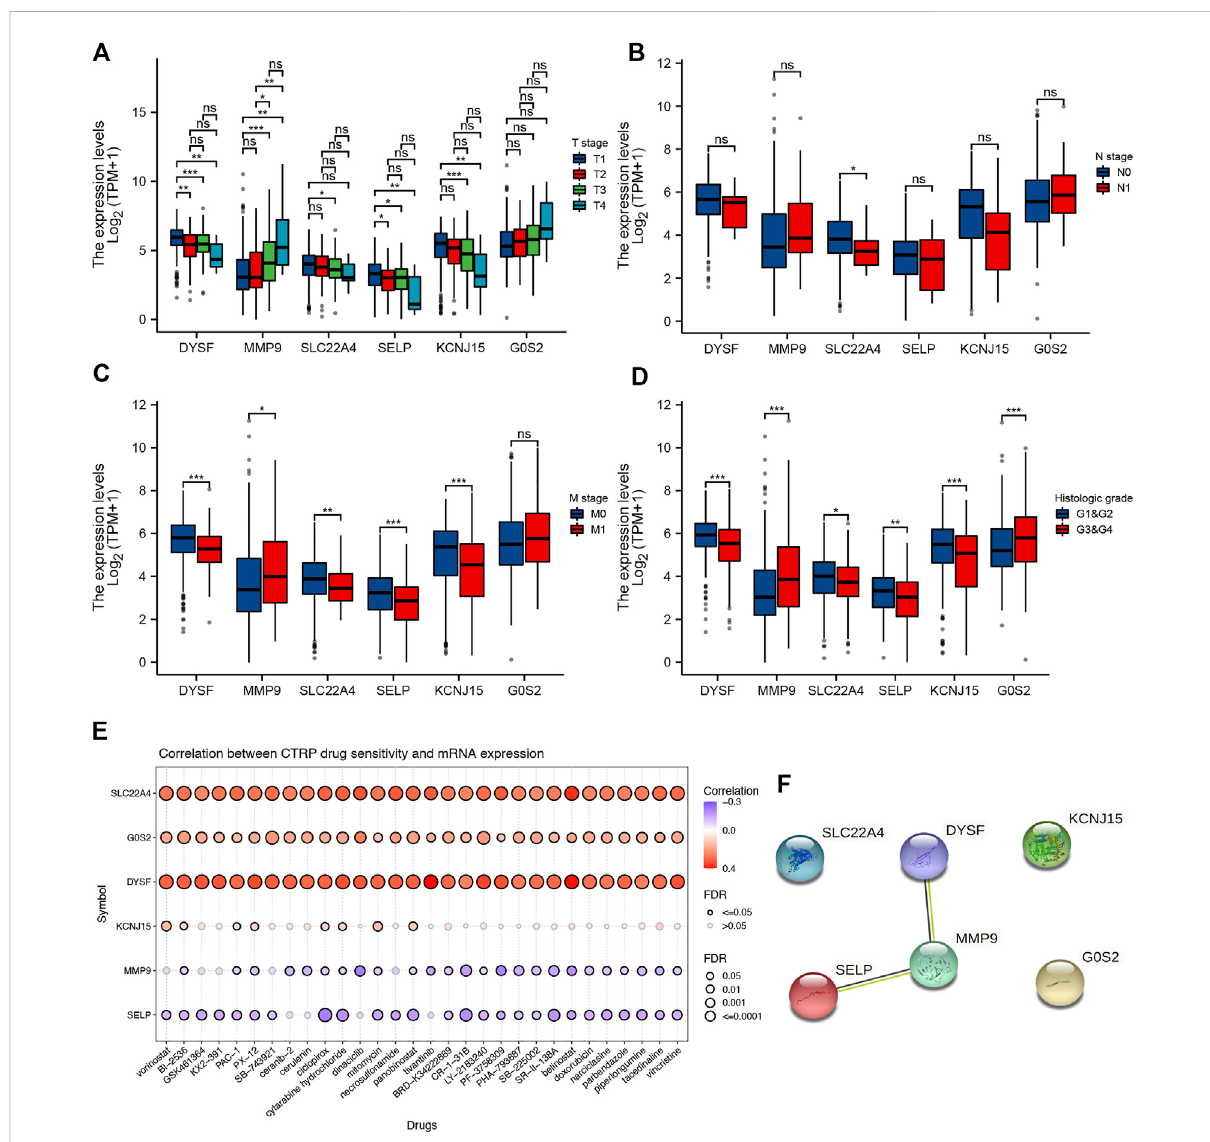
FIGURE 9 Prognostic signature gene analysis. Correlation between the pT stage (A) , pN stage (B) , pM stage (C) , tumor grade (D) , and the expression of prognostic signature genes in ccRCC. (E) Correlation between drug sensitivity and the expression of prognostic signature genes in ccRCC.